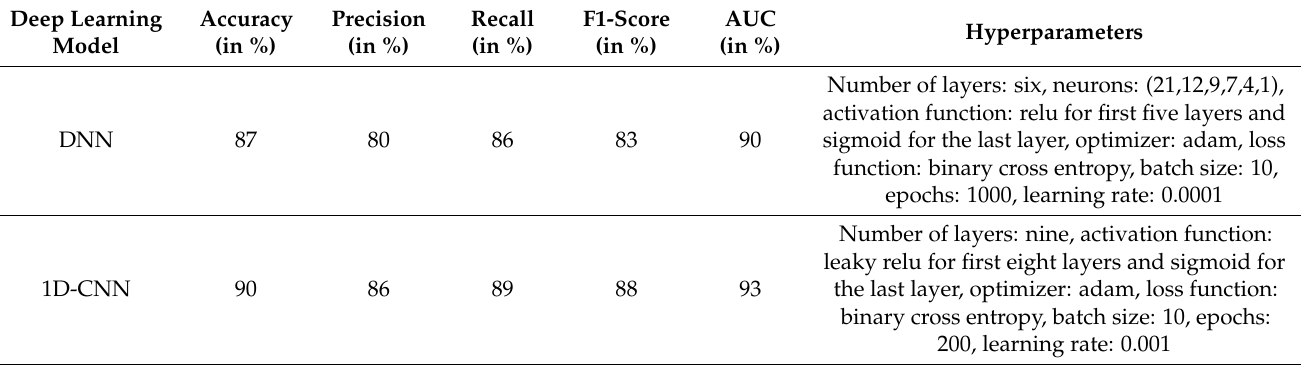
Table 7. Summary of results obtained by the DNN and 1D-CNN